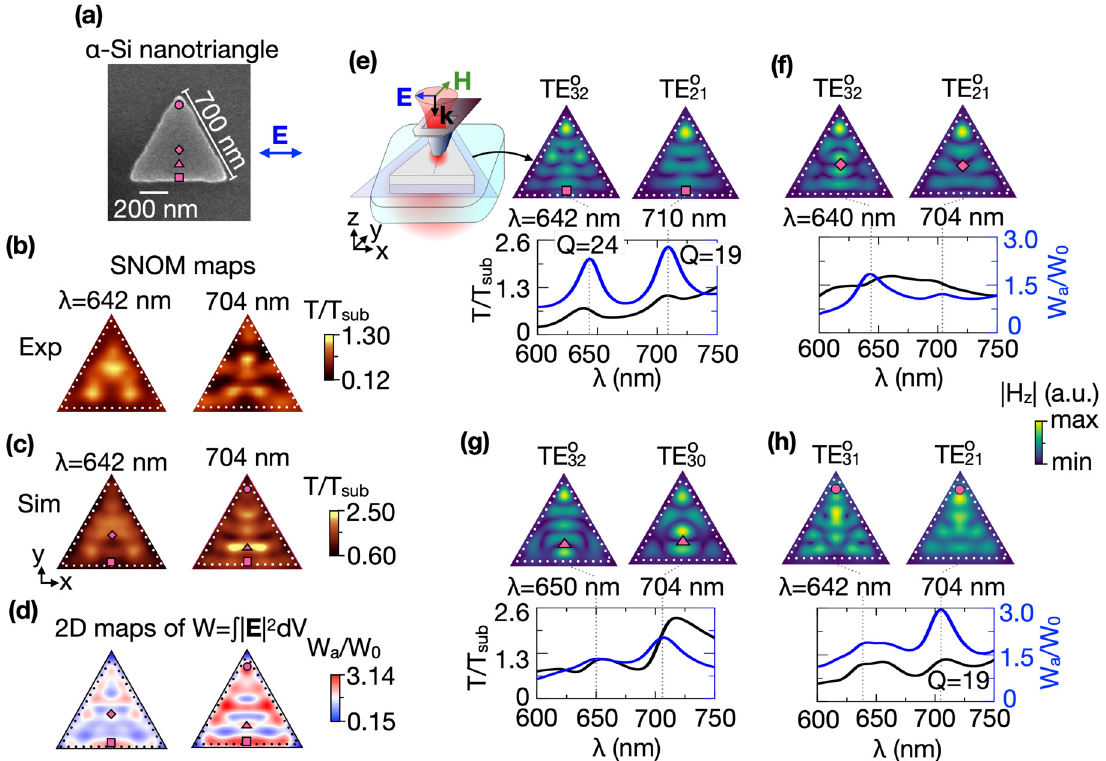
Figure 4: (a) SEM image of the equilateral 𝛼 -Si nanotriangle (the same as in Figure 3). The side length of triangle is 700 nm, and the thickness is 100 nm. The blue arrow indicates the x − polarization of light focused in the SNOM probe. Experimental (b) and simulated (c) SNOM maps of the 𝛼 -Si equilaterale nanotriangle for x − polarized excitation, respectively. The blue arrow indicates the x − polarization of /W at the same wavelengths of the SNOM maps in light focused in the SNOM probe. (d) Simulated 2D maps of electric field localization W 0 a (c). The circle ( x = 0 nm, y = 560 nm), square ( x = 0 nm, y = 80 nm), diamond ( x = 0 nm, y = 260 nm), and triangle ( x = 0 nm, y = 180 nm) symbols on (a), (c), and (d) depict the SNOM probe positions corresponding to maxima of electric field localization. (e–h) The simulated (black curves) and electric field localization W /W (blue curves) spectra recorded at the fixed positions of the SNOM transmittance T / T sub 0 a | distributions of /W (d) maps. The top rows in (e–h) show the simulated | H SNOM probe marked as purple symbols on SNOM (c) and W 0 a z | field was taken at central xy − cross-sections of the nanotriangle as shown in the sketch in panel (e). Dotted white and modes. The | H TE o z mn black lines indicate the boundary of the